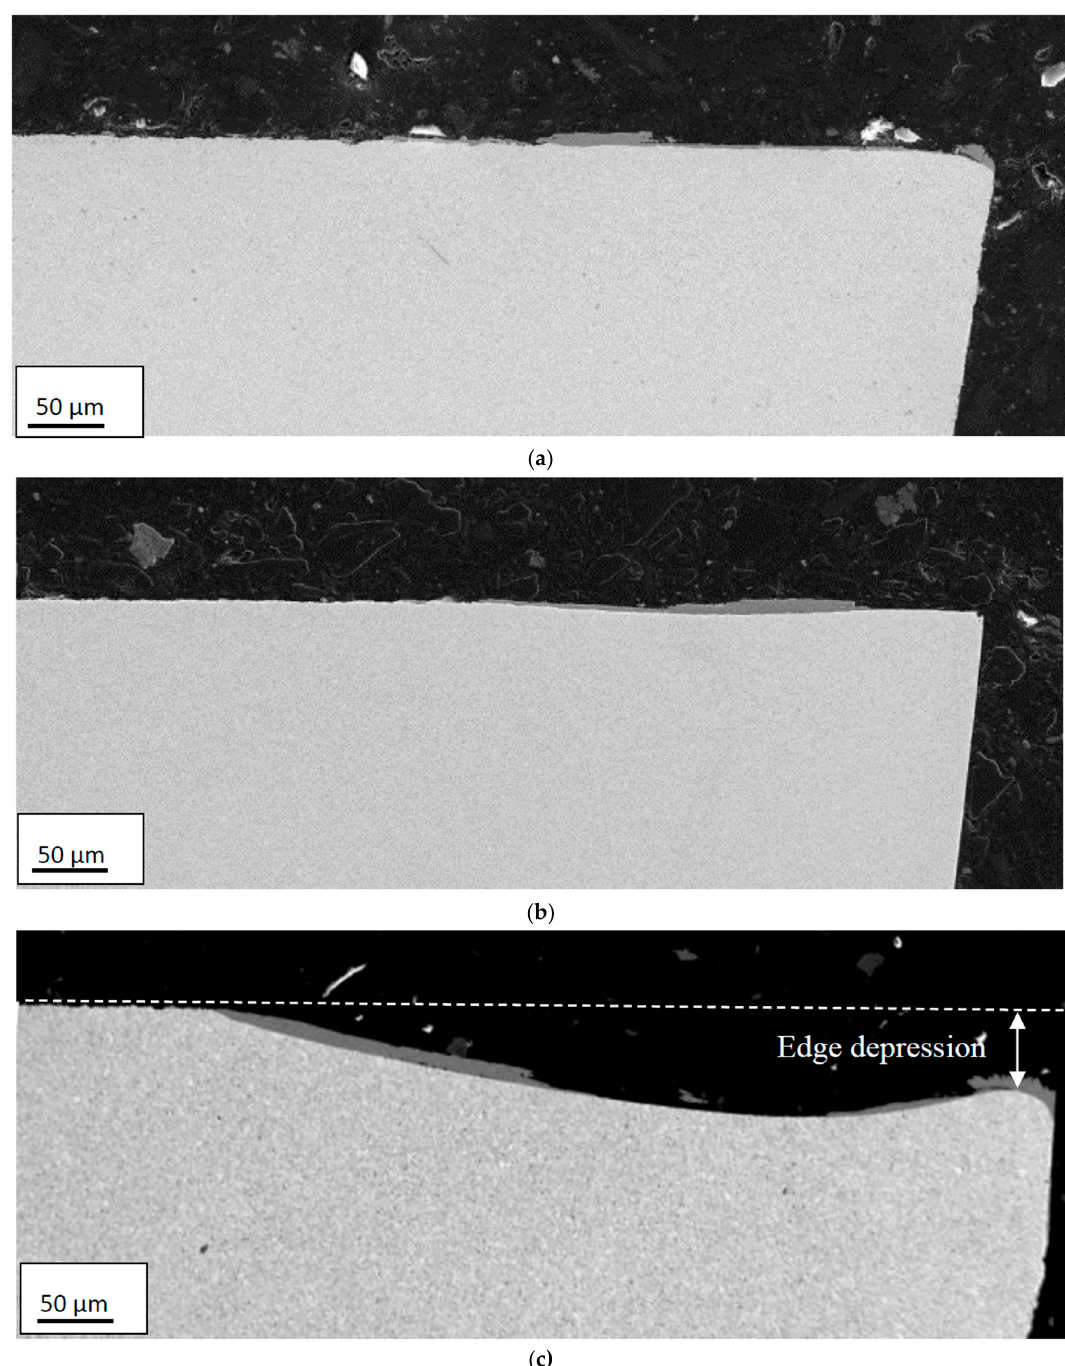
Figure 10. Cross-sections illustrating the influence of cutting speed on the resulting crater and flank wear characteristics. ( a ) 45 m/min; ( b ) 60 m/min; ( c ) 90 m/min. Feed rate: 0.2 mm/rev, Time: 3 min.